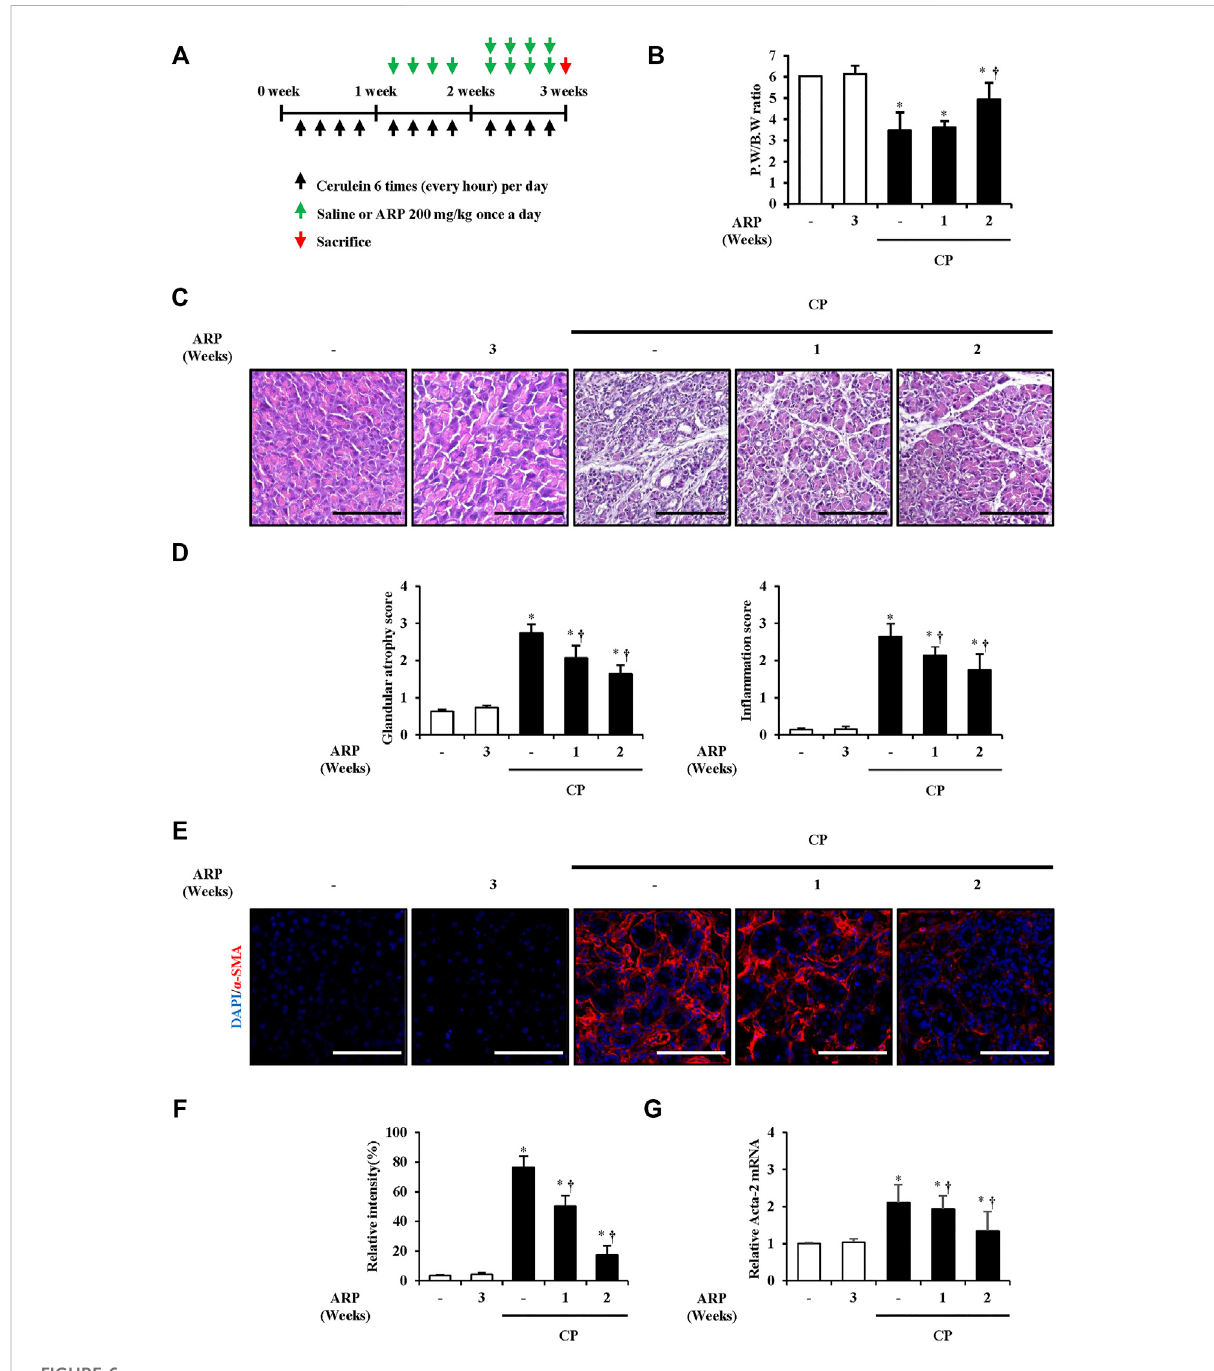
including diverse types of collagen and fi bronectin, increases in this area (Schneider et al., 2001; Krieg et al., 2007; Apte et al., 2011). Thus, we examined whether ARP reduces the above- mentioned factors which are increased in CP, as reported previously (Barnes et al., 1999; Bachem et al., 2006;